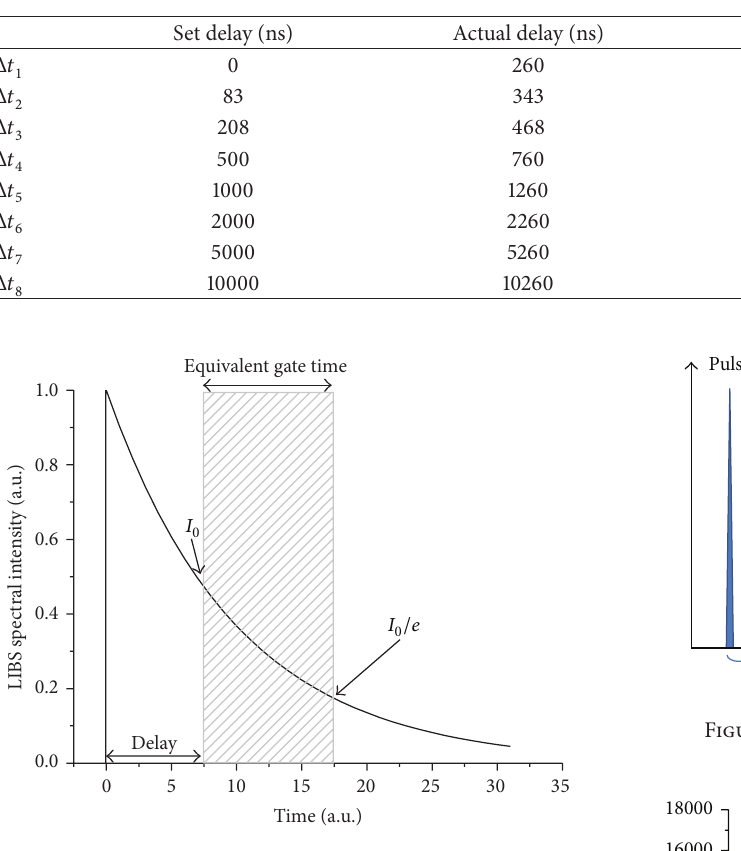
Figure 1: Equivalent gate time in time-integrated LIBS analysis.